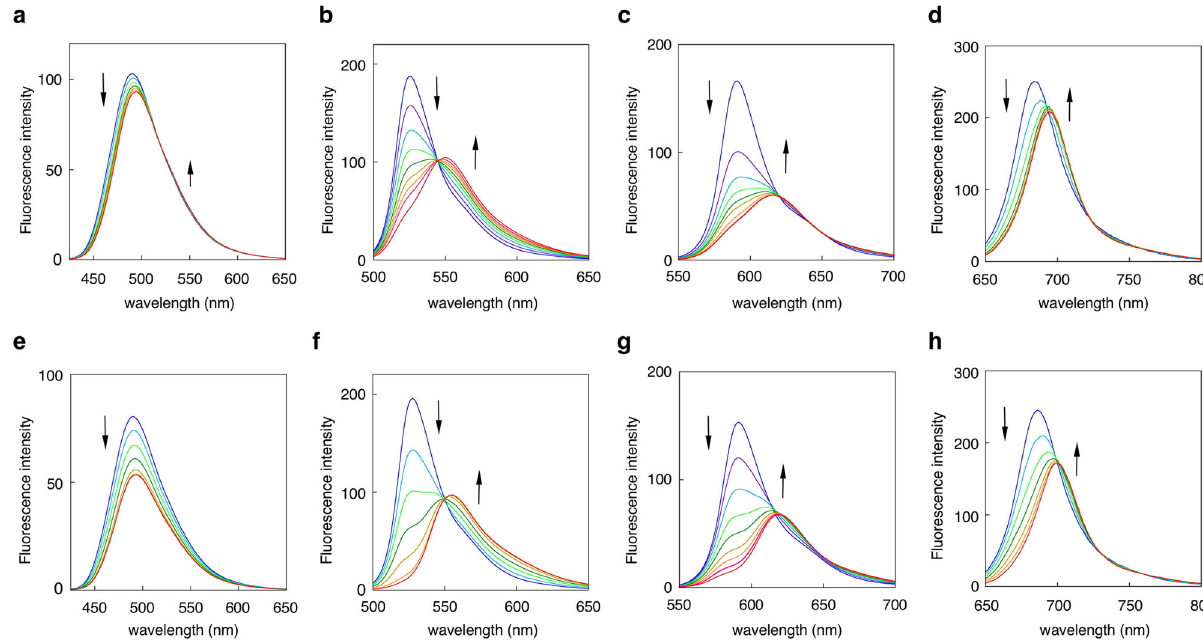
Fig. 4 Fluorescence response of AM-contact probes toward metal ions. Fluorescence spectral changes of probes 8 – 11 (from left to right) upon the addition of ZnCl 2 ( a – d ) or CdCl 2 ( e – h ). Measurement conditions: [probe] = 5 μ M ( 9 , 10 , 11 ) or 10 μ M ( 8 ), 50 mM HEPES (pH 7.4)/MeOH = 1:1, 25 °C.